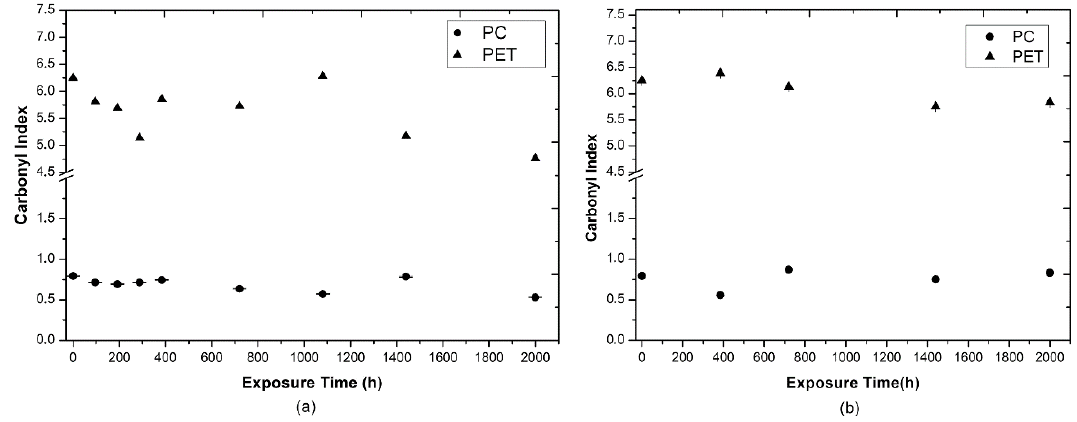
Figure 4. Carbonyl index as a function of exposure time for (a) natural and (b) accelerated